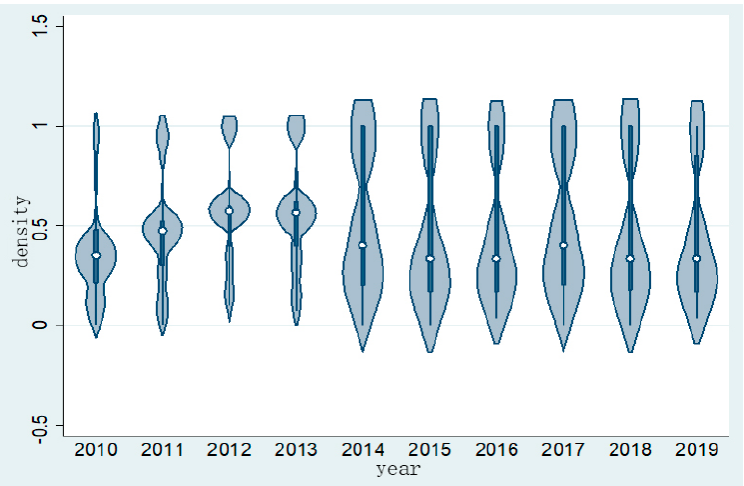
Figure 4. Violin diagram of knowledge-based network density .